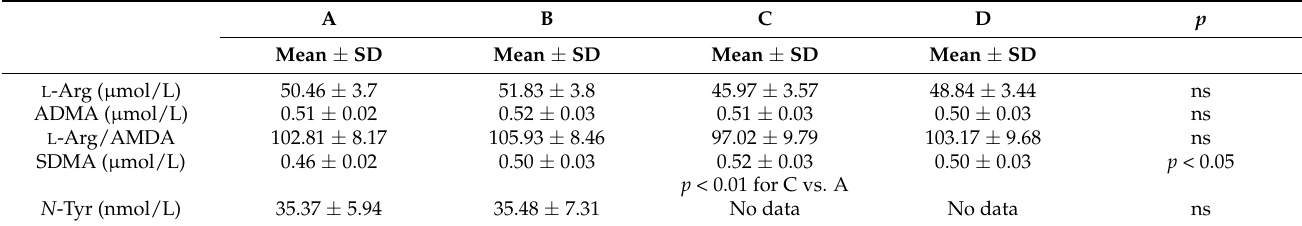
Table 4. Comparison of the nitric oxide bioavailability parameters in the hypertensive subjects (Group H) at particular steps of the study protocol.